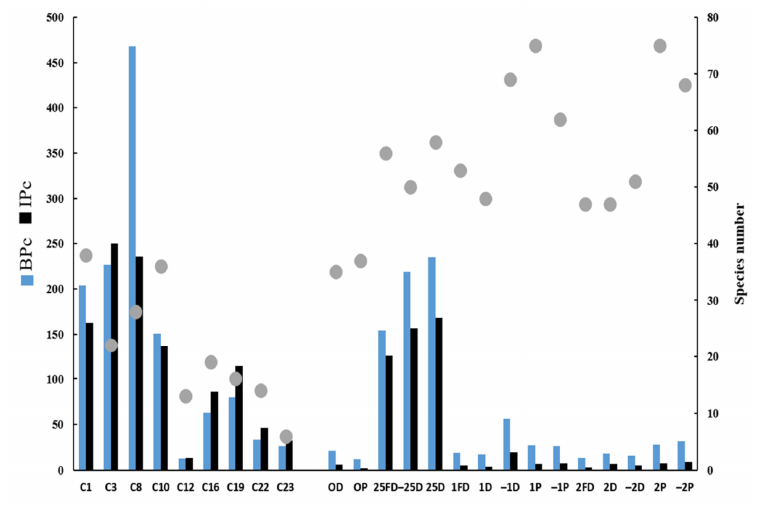
Figure 3. Total bioturbation potential (BP c ) and irrigation potential (IP c ) of community and species number in di ff erent sampled areas.